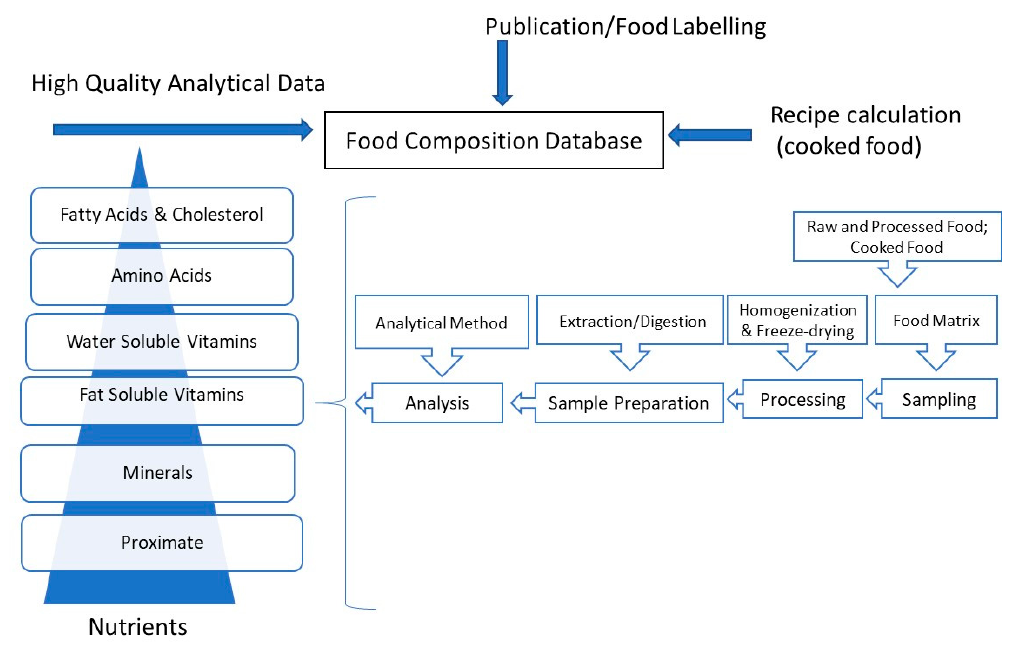
Figure 1. Overview of process in analyzing food for Food Composition Database.